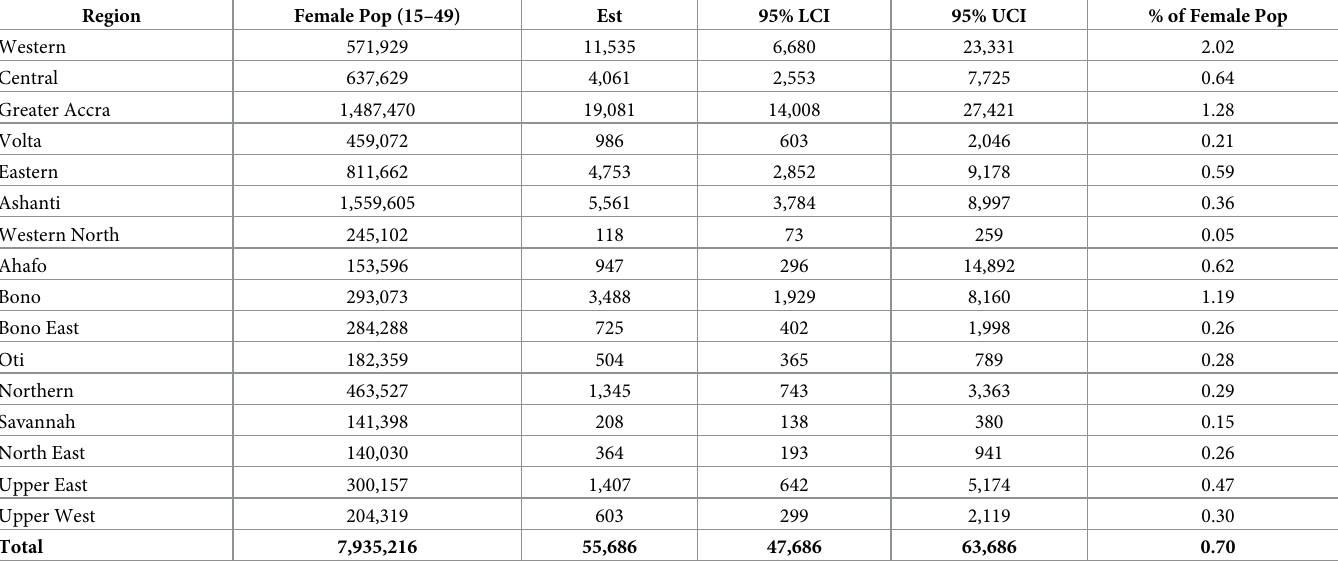
Table 2. Population size estimate of FSW using 3 source capture-recapture for roamers by region in Ghana, 2020. Region